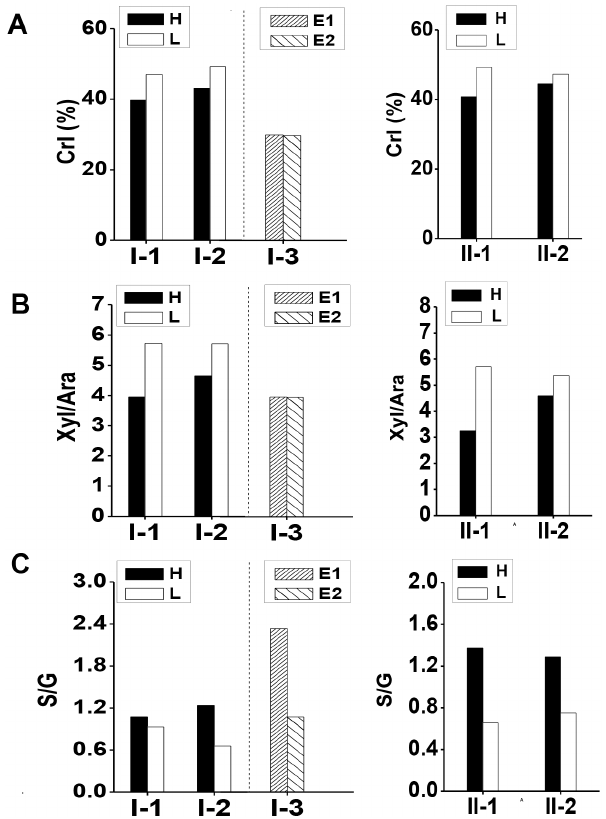
Figure 3. Detection of cell wall features in typical five pairs of corn samples. ( A ) Lignocellulosic CrI of raw material. ( B ) Xyl/Ara ratio of the non-KOH-extractable hemicelluloses; ( C ) S/G ratio of the non- KOH-extractable lignin. H/L/E Indicated as relatively high/low/equal biomass digestibility at pair.